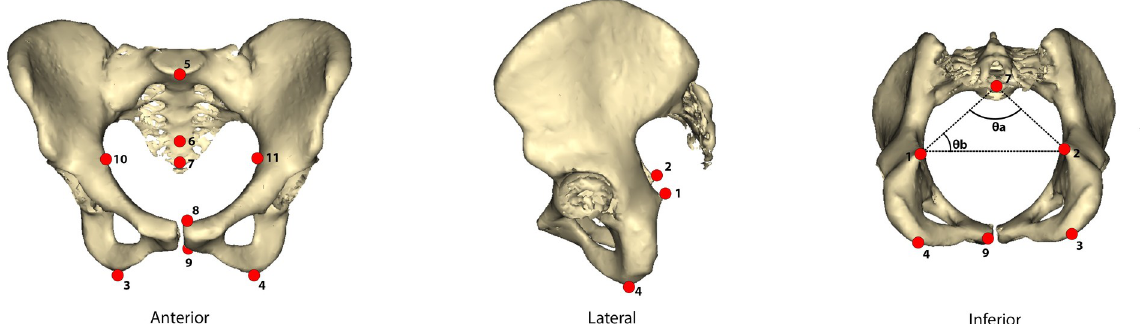
Fig 2. Canal landmarks. Eleven landmarks, shown as red circles, were taken on 3D models of pelves to represent the canal. One pelvis is shown here from the anterior, lateral, and inferior points of view.